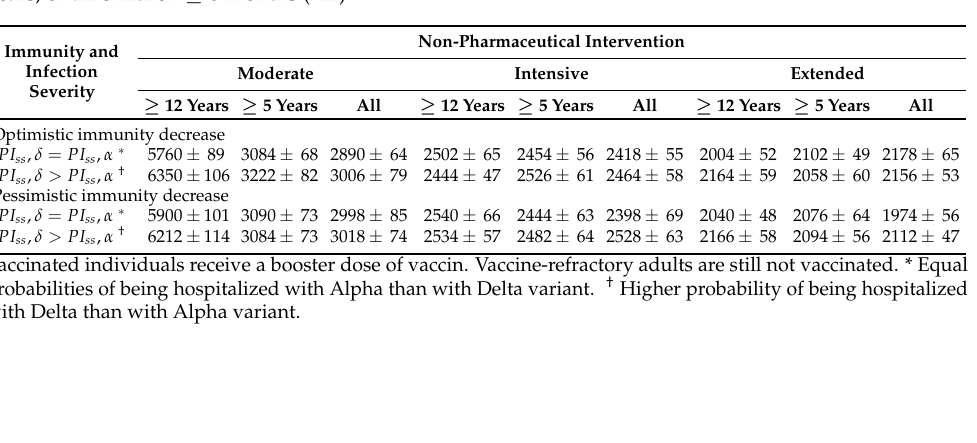
Table 6. Number of deaths ± SEM over 400 days in hypothetical combinations of non-pharmaceutical intervention levels, immunity decrease, and infection severity, with vaccinating children ≥ 12 years, ≥ 5 years, or all children ≥ 6 months